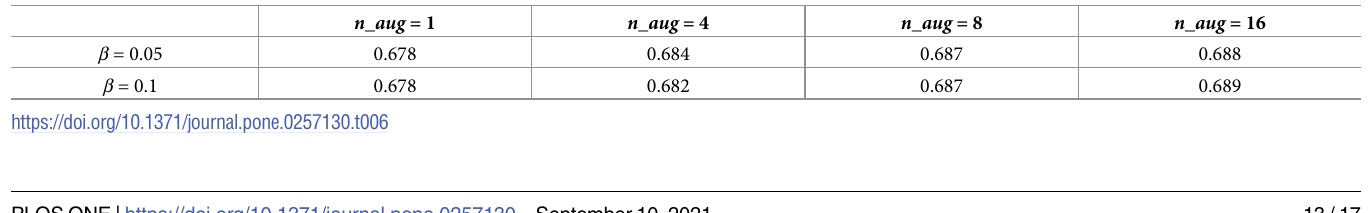
Table 6. The comparison of EDA data and original data on the model. Within, we set n_aug = 1 represents the result of the original data without EDA on the